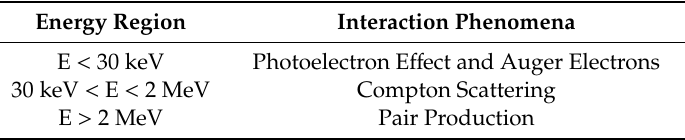
Table 2. Gamma interaction with the energy